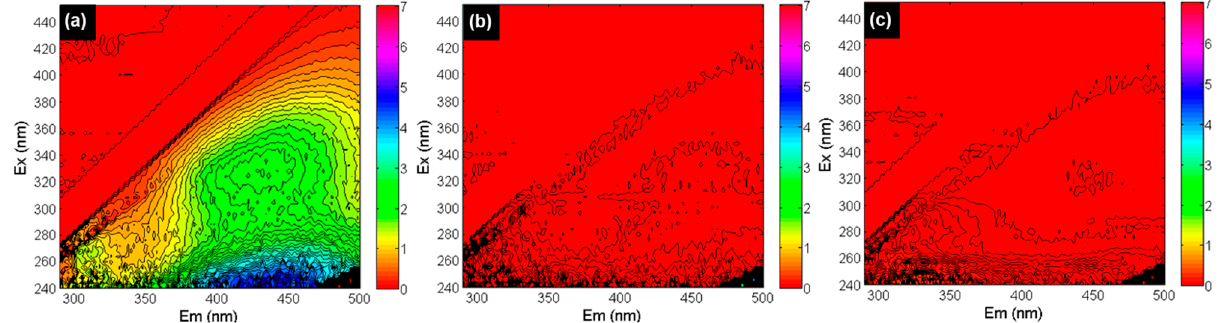
Figure 8. FEEM analysis of the ( a ) RO concentrate at 85 % recovery, ( b ) 0.05 M NaOH cleaning solution, and ( c ) 0.05 M HCl cleaning solution (Ex and Em represent excitation and emission wave-